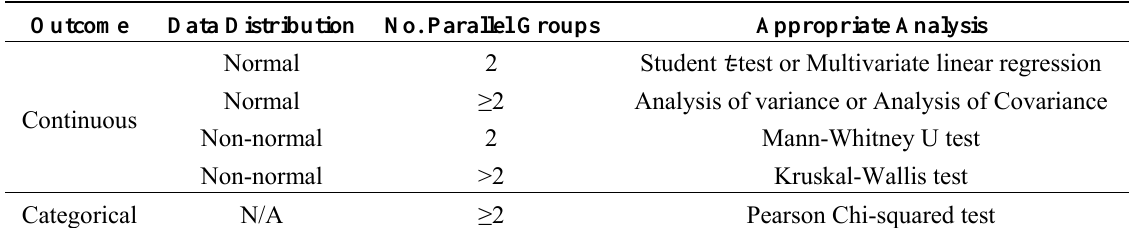
Table 1. Appropriate statistical analysis for between-group